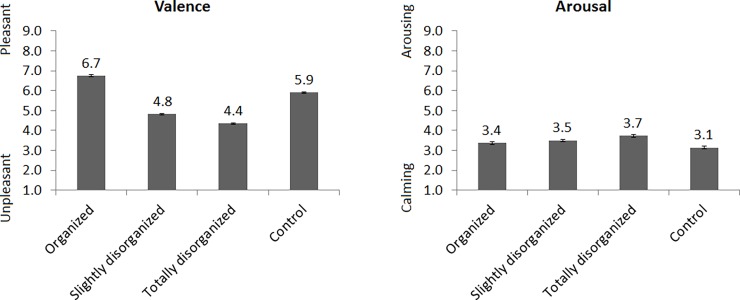
Valence and arousal ratings for each of the four conditions.Error bars indicate standard error of the mean.